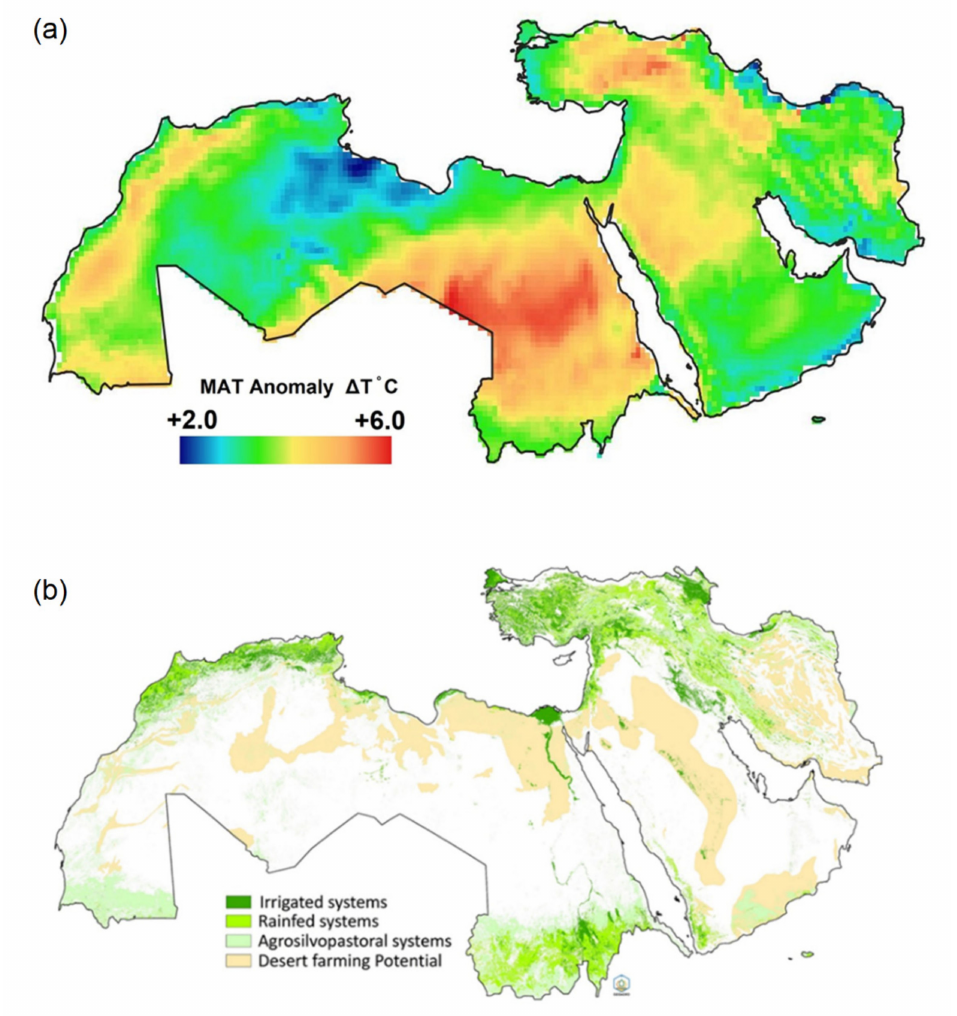
Figure 1. ( a ) The climate vulnerability map of the MENA region derived from the RICCAR climate product [16] by analying 1980–2100 for RCP8.5 and RCP 4.5 to show the temperature difference map ( ∆ T) of the mean annual temperature between 1980 and 2100 for RCP 8.5 which is business as usual climate scenario. ( b ) The spatial distribution of the four main agroecosystems in MENA viz. rain fed, irrigated, agro-pastoral rangelands and desert agriculture, developed using satellite remote sensing and spatial